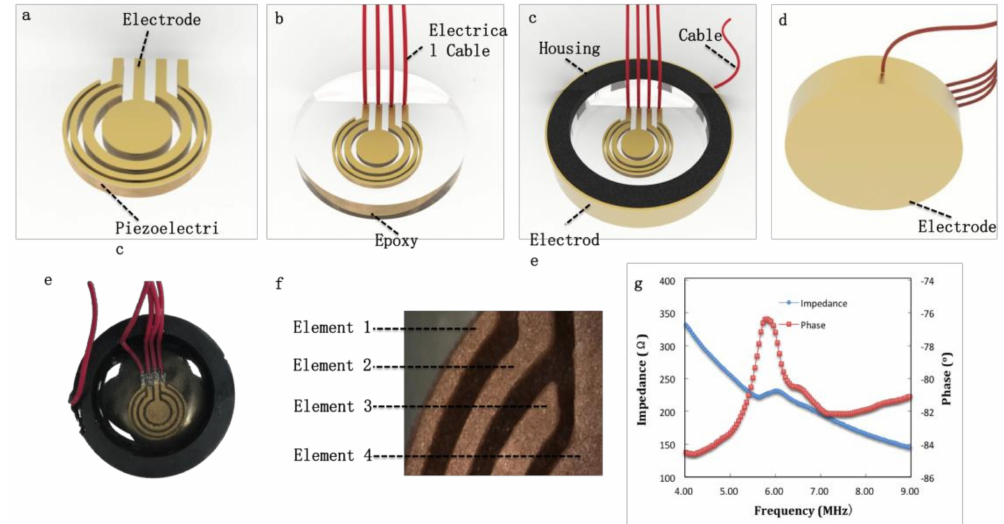
Figure 3. ( a – d ) Structure of annular array transducer. ( e ) Optical image of annular array transducer. ( f ) Four elements of annular array. ( g ) Element’s spectrum of impedance and phase.